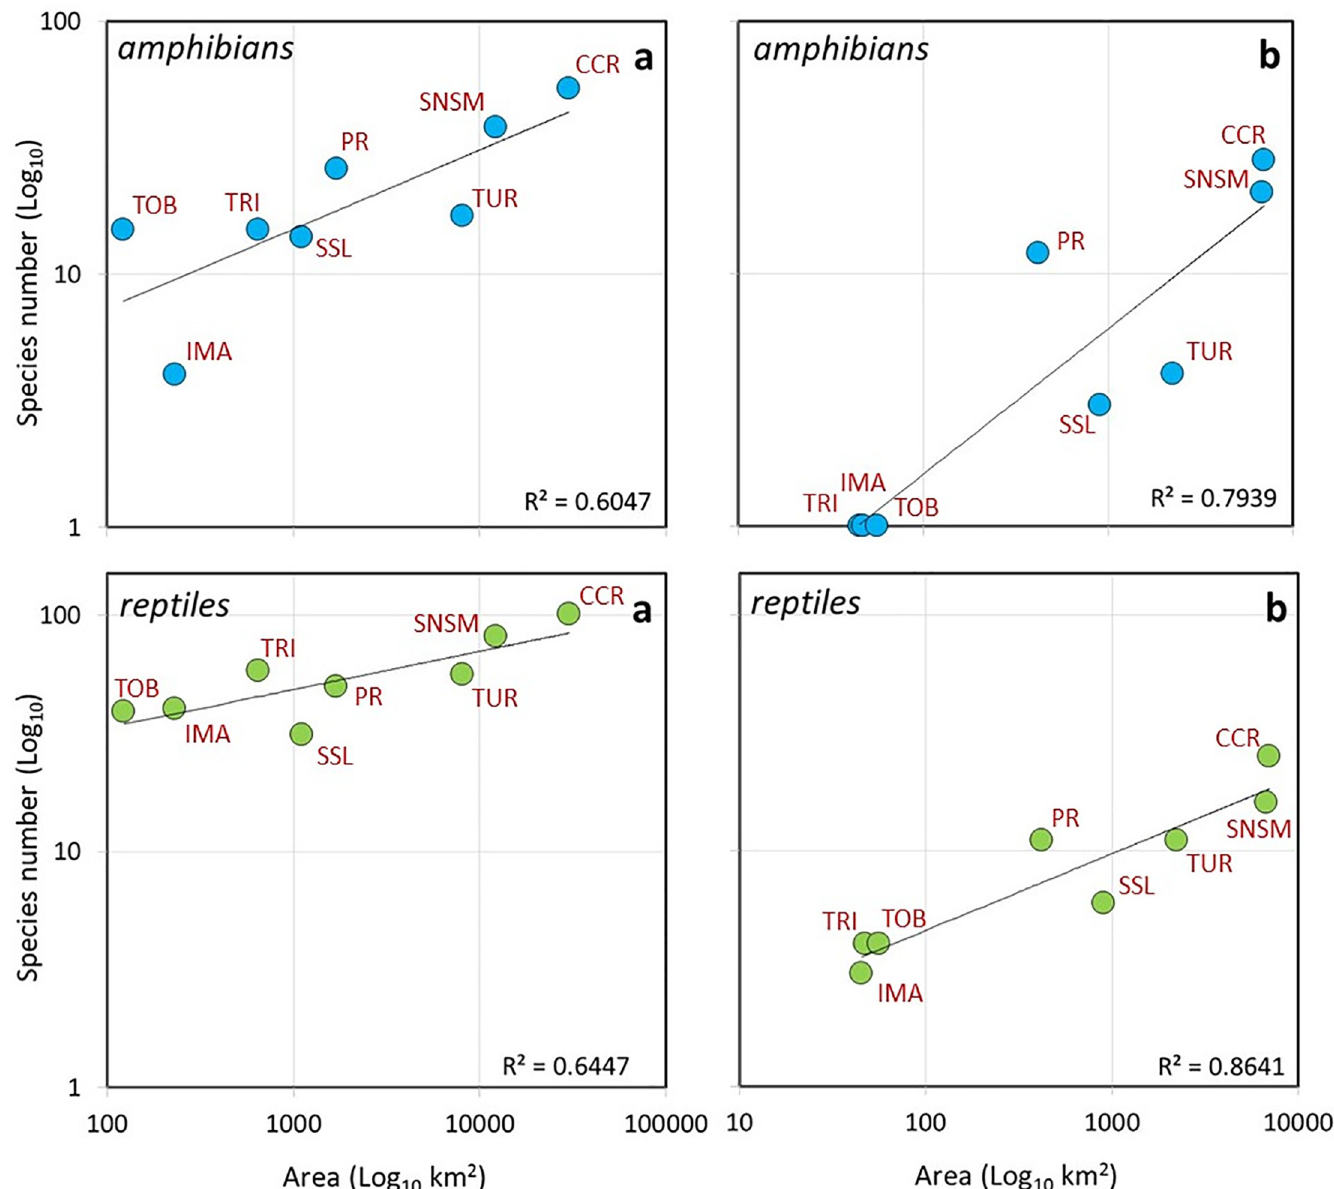
Fig 3. Species-area relationships using the linear function for (a) amphibians (blue circles) and (b) reptiles (green circles). The two graphs on the left (a) are from species-area calculated above 200 m in elevation and the two right graphs labelled (b) are from species-area calculated from mid mountain vegetation. SNSM (Sierra Nevada de Santa Marta, Colombia), SSL (Sierra de San Luis), CCR (Central Coastal Range), IMA (Isla de Margarita), TUR (Turimiquire Massif), PR (Paria Range), TRI (island of Trinidad), TOB (island of Tobago).